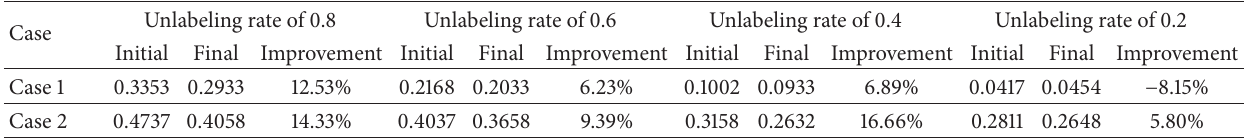
Table 6: Classification error rate of initial and final hypothesis and the corresponding improvements of self-training under different unlabeling rate.